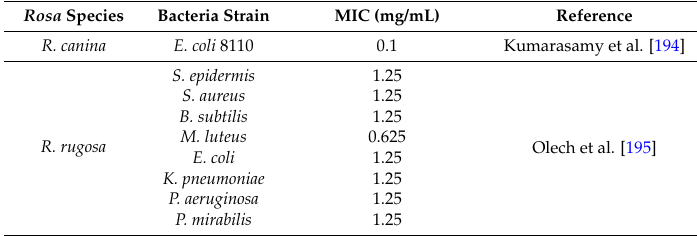
Table 4. Antibacterial effect of some Rosa species displayed as minimal inhibitory concentration (MIC).